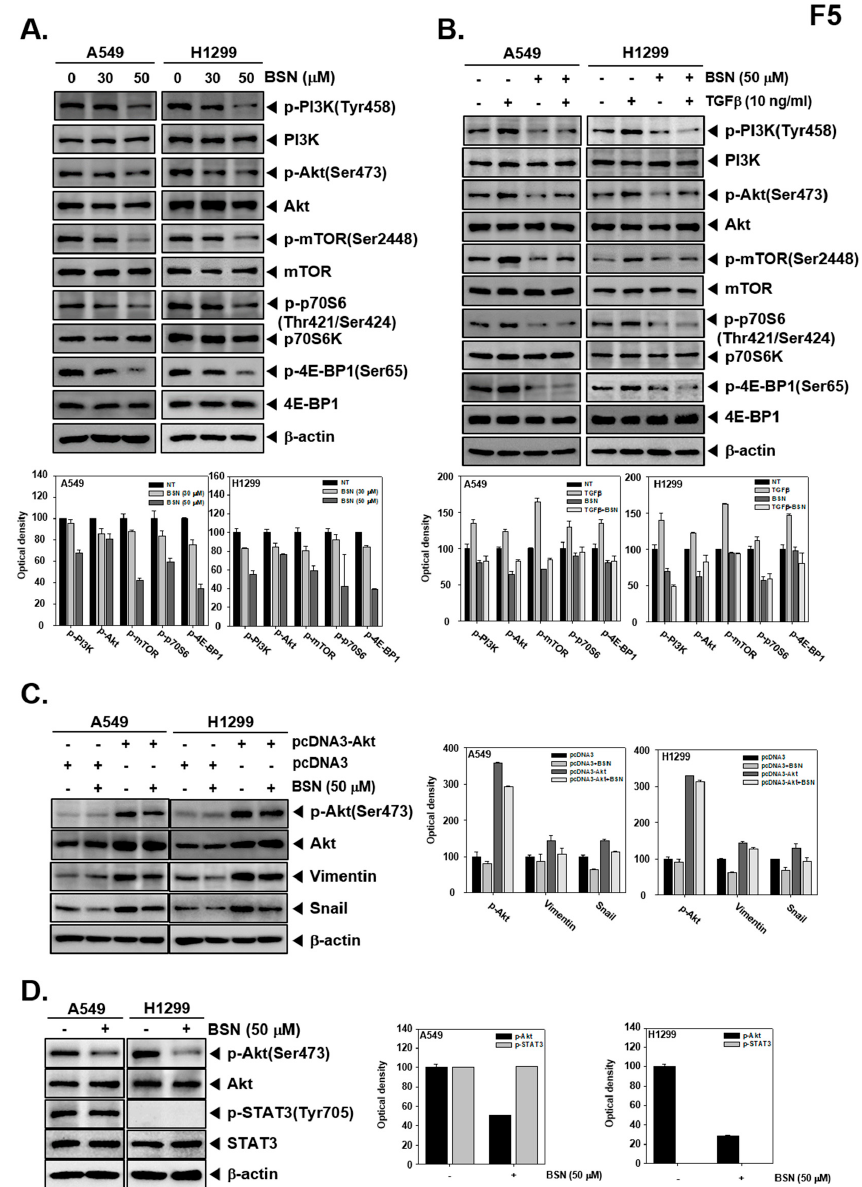
Figure 5. Effect of BSN on phosphoinositide-3-kinase (PI3K)/protein kinase B (Akt) in TGF- β -treated Figure 5. E ff ect of BSN on phosphoinositide-3-kinase (PI3K) / protein kinase B (Akt) in TGF- β